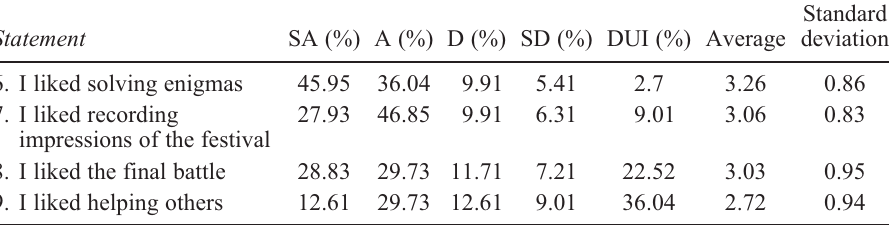
Table 4. Results of the related parts of the paper questionnaire for TekMyst.